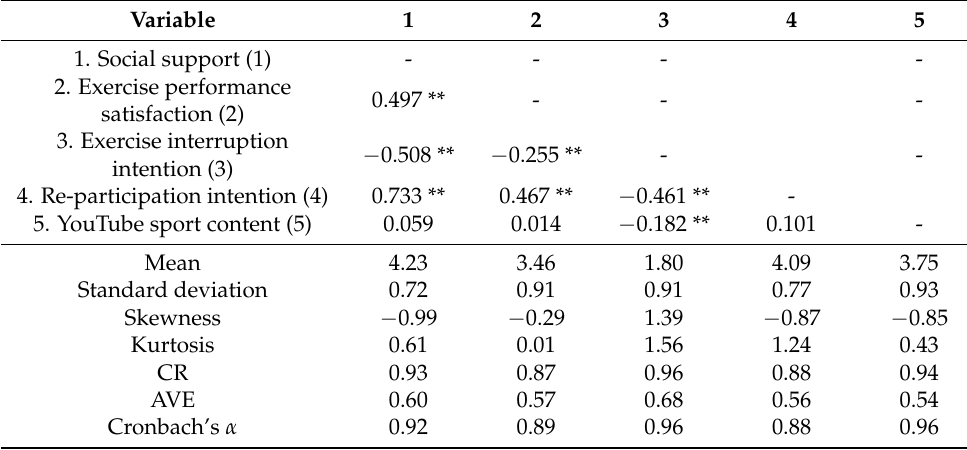
Table 1. Descriptive statistics, Pearson correlations of scores, and Cronbach’s α .